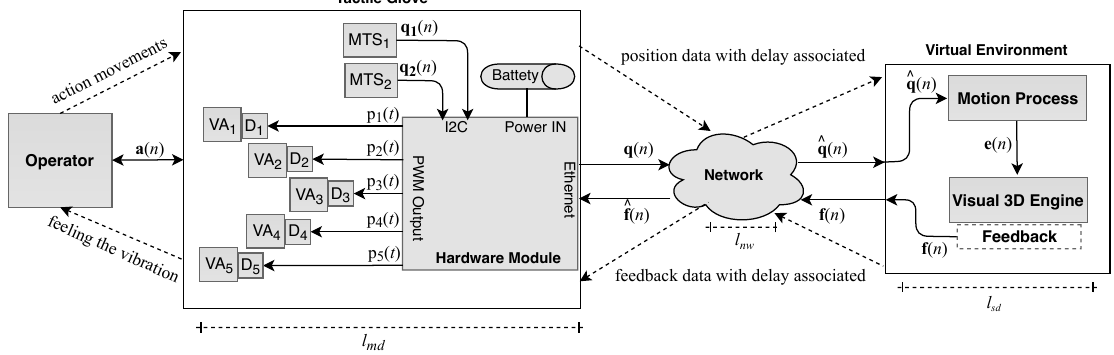
Figure 2. Block diagram of the human-to-machine tactile system